Question: Provide a one-line summary of what is displayed.
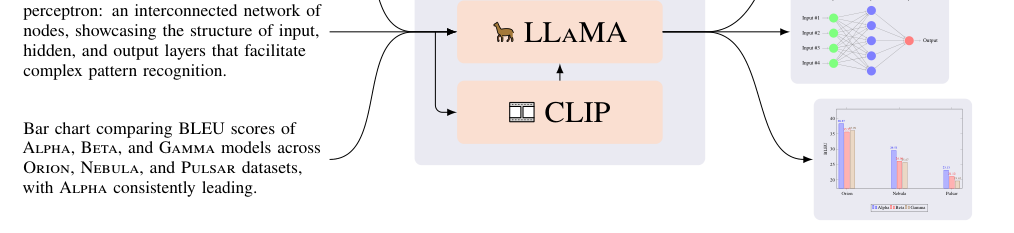
Answer: Exemplary scientific figures generated with CLiMA. CLiMA takes the captions as input, processes them with CLIP and LLaMA, and generates TikZ drawings that compile to vector graphics.